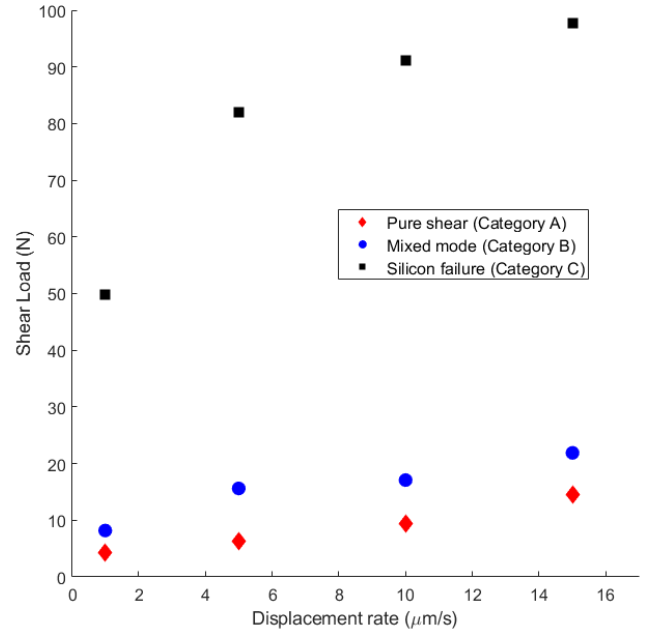
Figure 15. Dependency of the failure load with respect to the strain rate.